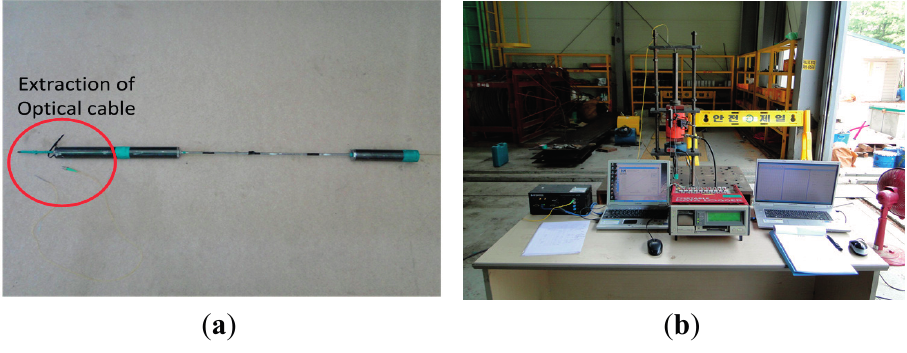
Figure 4. ( a ) Carbon core wire specimen for sensing strand and ( b ) setting of core wire